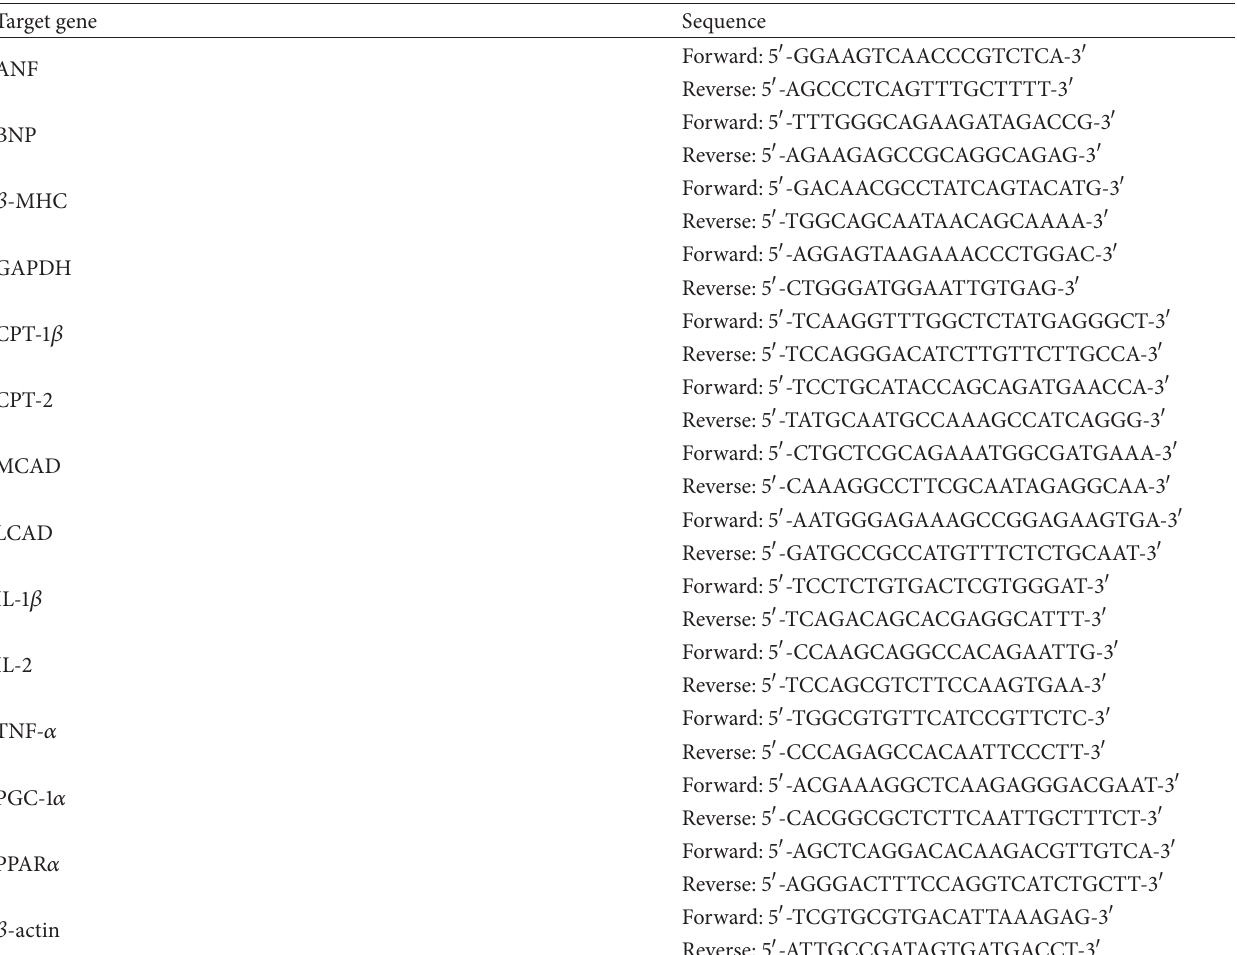
Table 1: Primer sequences for